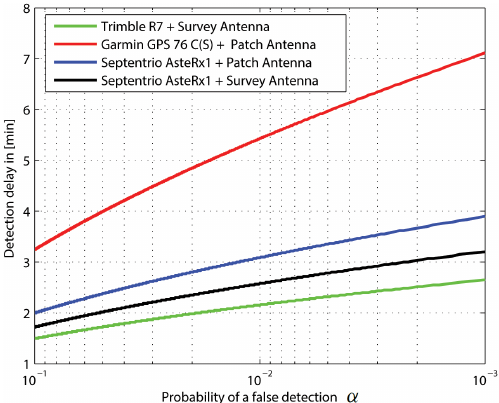
Figure 10. This graph shows the probability of detection γ as a function of the detection delay in time. The level of significance is set at α =0.05. Zero detection delay corresponds to the very mo- ment the observed extension e is equal to the extension related to slack tide e st . At this particular moment α = γ . As time progresses the probability of detection γ increases until γ